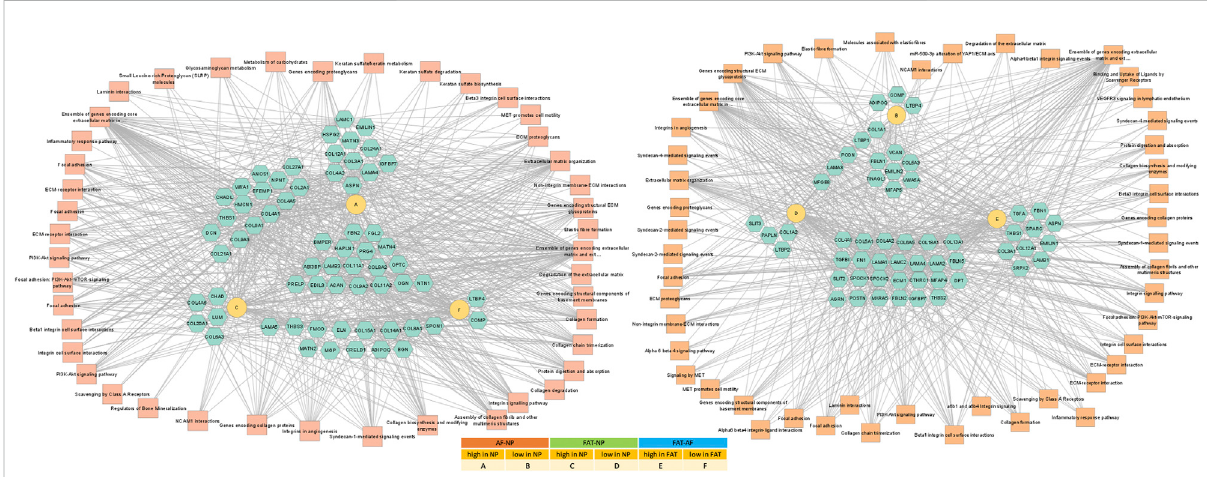
FIGURE 5 Network of differentially expressed transcripts between annulus fi brosus (AF) and nucleus pulposus (NP) cells of the IVD and adipose (FAT) stromal cells associated with the functional enrichment term extracellular matrix structural constituent (GO:0005201). Networks were generated with ToppCluster and analyzed in Cytoscape. Cells were isolated from a single donor to avoid the genotype effect. Cells were analyzed as three replicates for AF and NP and two replicates for FAT cells. Nodes are identi fi ed in the